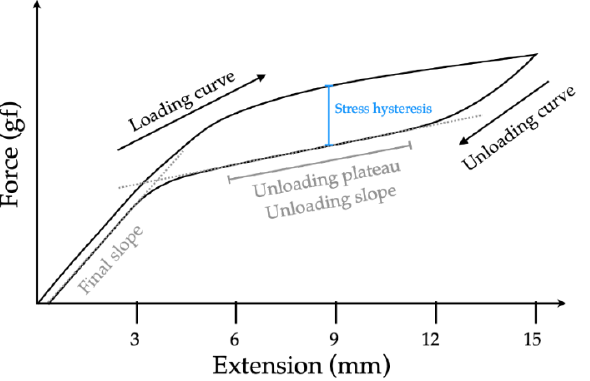
Figure 2. A load-extension curve illustrating loading and unloading curve, unloading plateau/slope, and final slope of deactivation curve, as well as stress